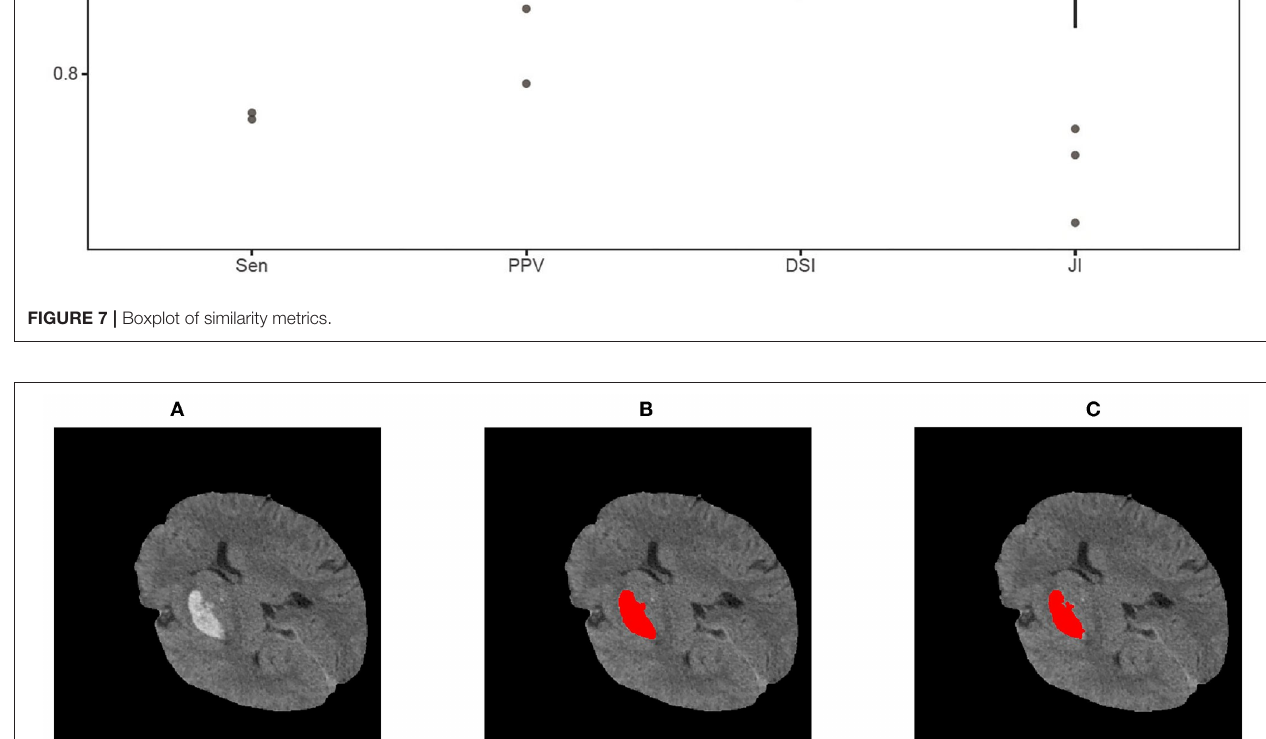
FIGURE 8 | Segmentations by different approaches: (A) the original image; (B) segmentation by standardized U-net; (C) segmentation by the RG-WP